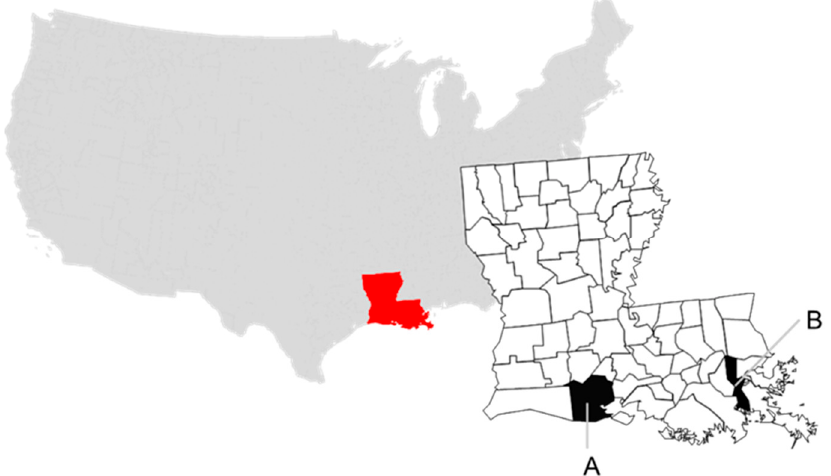
Figure 1. Collection sites in Louisiana, USA at parish level and by sampling year for this study: ( A ) Vermilion, 2018, and ( B ) Jefferson, 2019. ( A ) Vermilion, 2018, and ( B ) Jefferson,